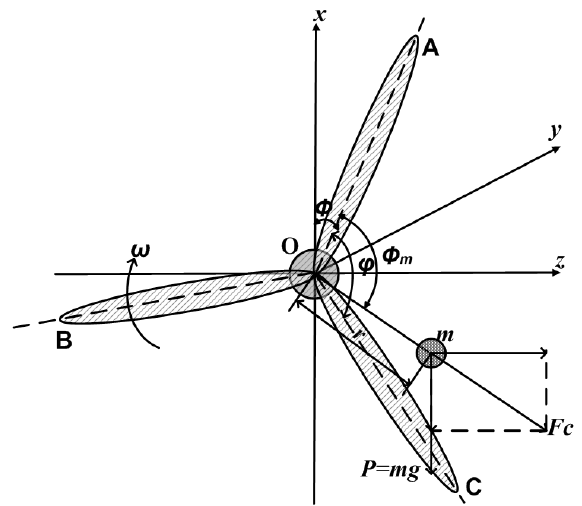
Figure 3 . Mass imbalance model.